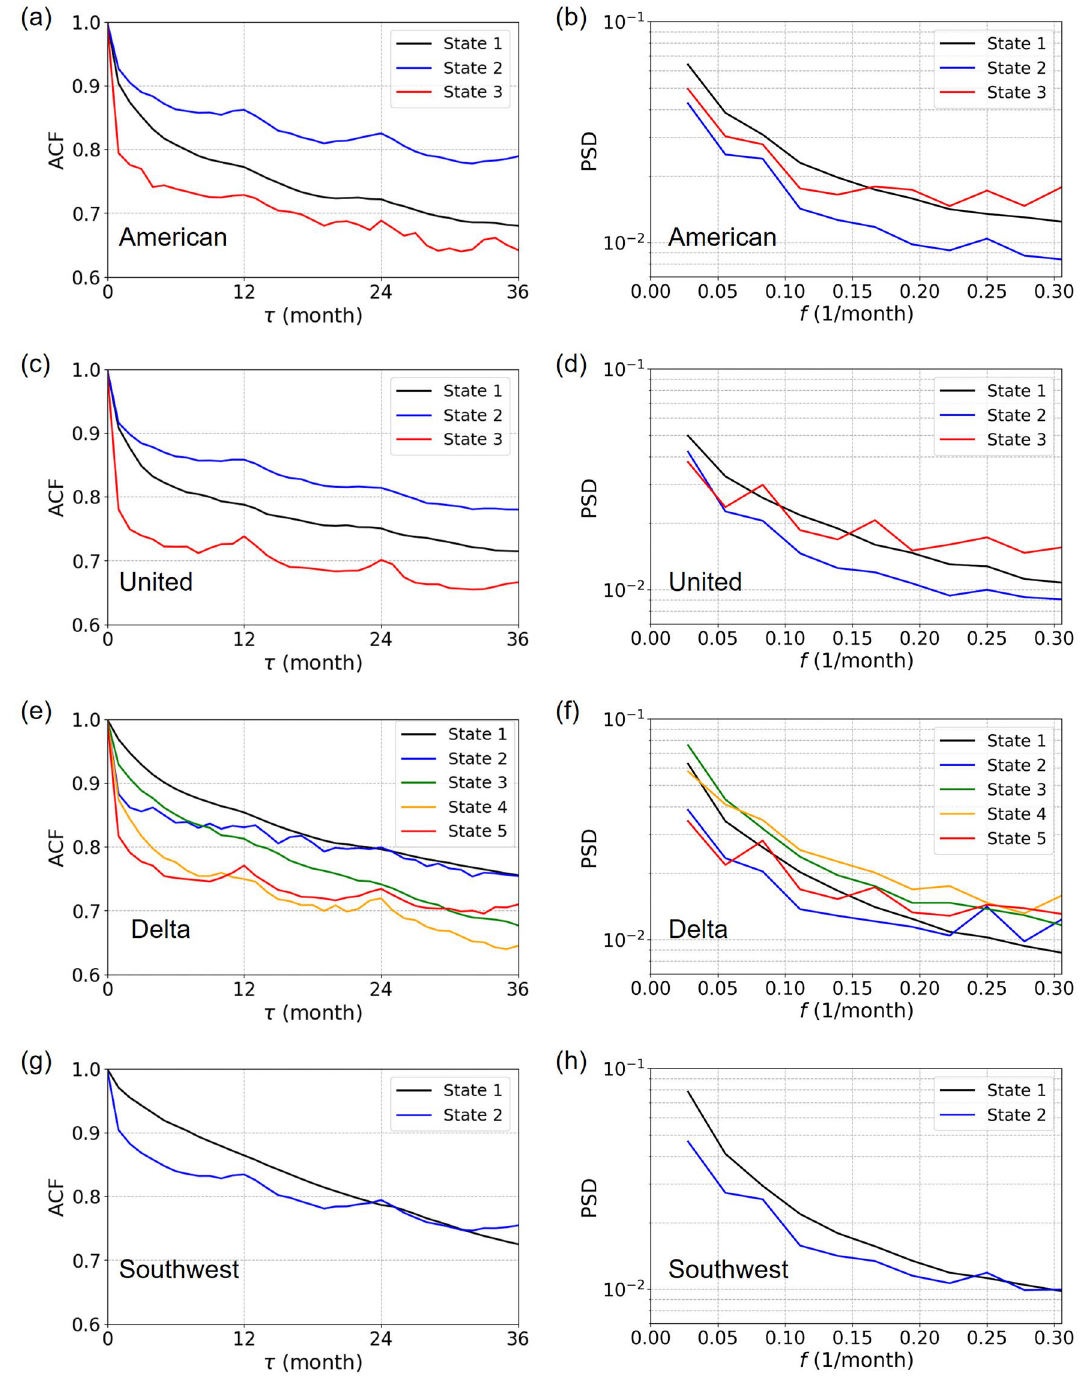
Figure 8. ACFs and PSDs for each network state. ( a ) American Airlines, ACF. ( b ) American Airlines, PSD. ( c ) United Airlines, ACF. ( d ) United Airlines, PSD. ( e ) Delta Air Lines, ACF. ( f ) Delta Air Lines, PSD. ( g ) Southwest Airlines, ACF. ( h ) Southwest Airlines,